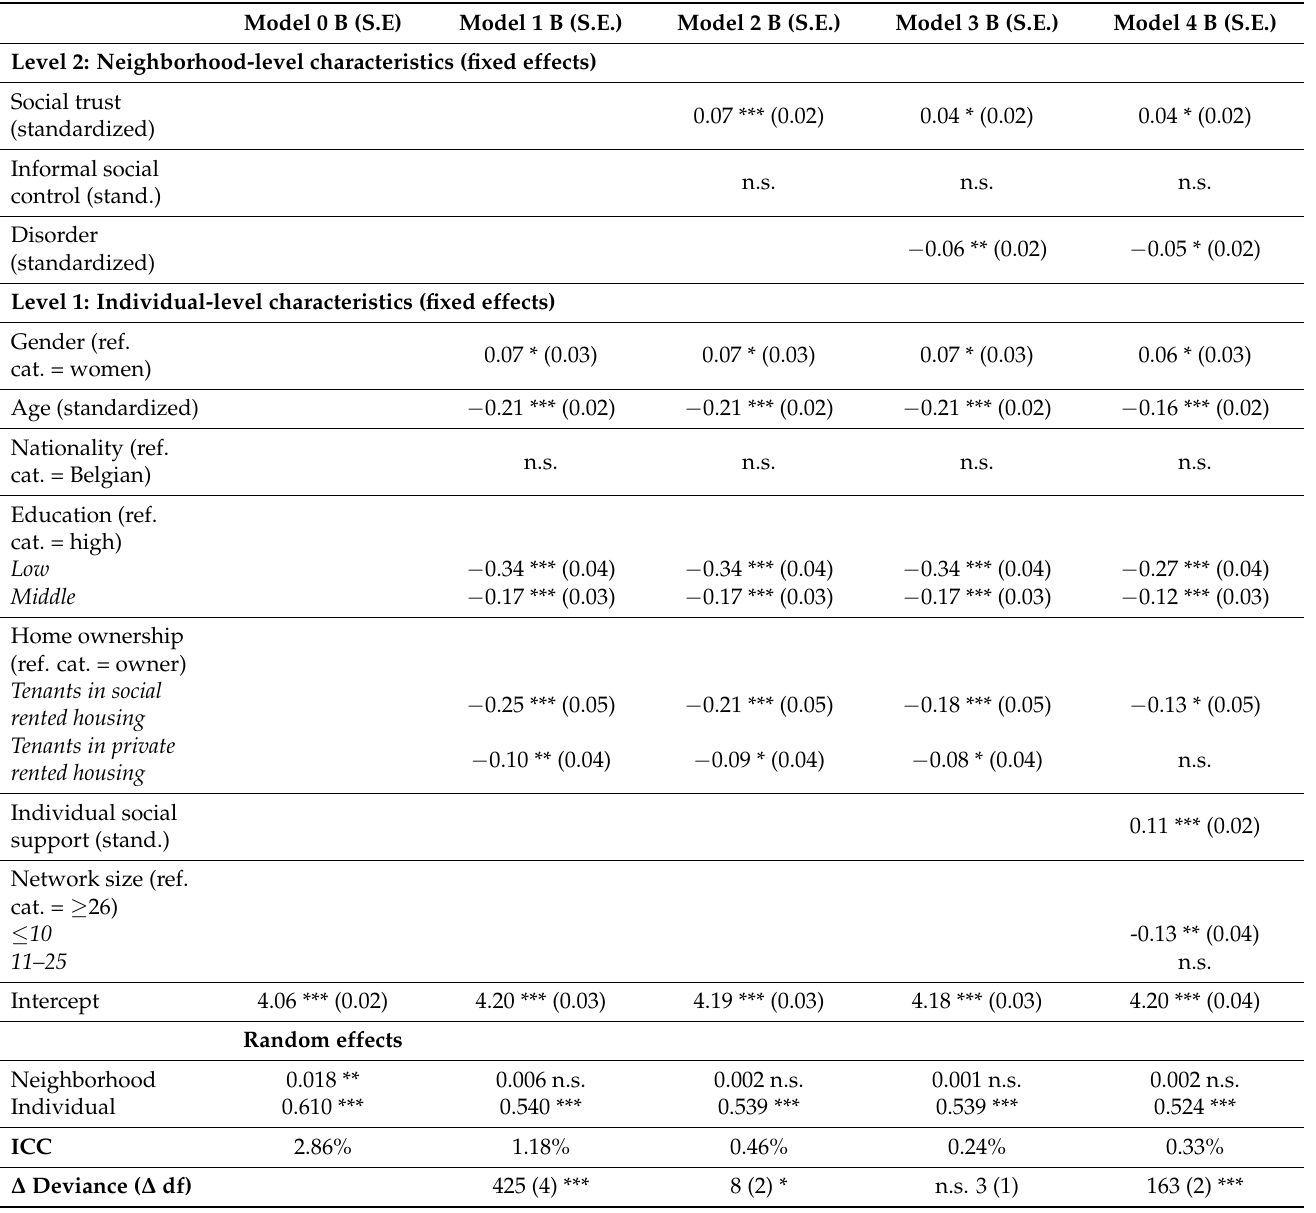
Table 3. Estimates (and standard errors) of the hierarchical linear models explaining self-rated health ( N =